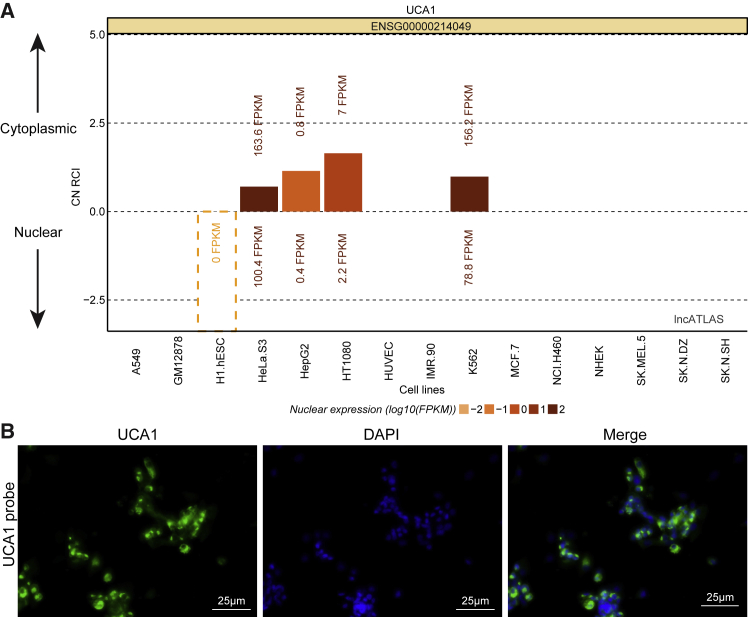
UCA1 Is Mainly Localized in the Cytoplasm of GC Cells(A) Bioinformatics analysis predicted that UCA1 is located in the cytoplasm of GC cells. (B) FISH assay (original magnification ×400) verified that UCA1 is located in the cytoplasm of GC cells.